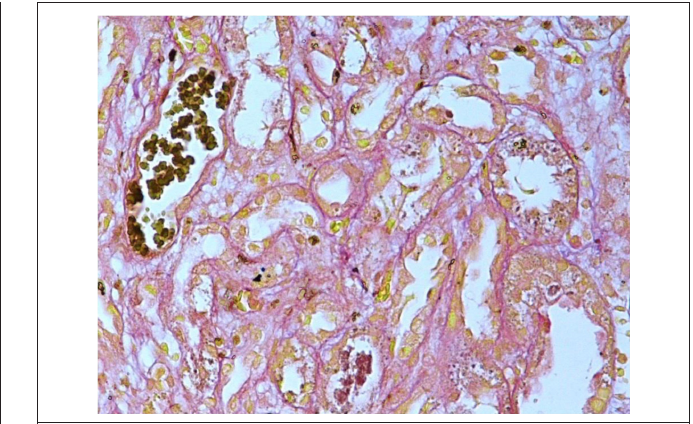
Figure 1. Representative area of kidney biopsy showing acute tubular necrosis and bile pigments in tubular epithelial cells (HE, × 400). HE, hematoxylin and eosin.